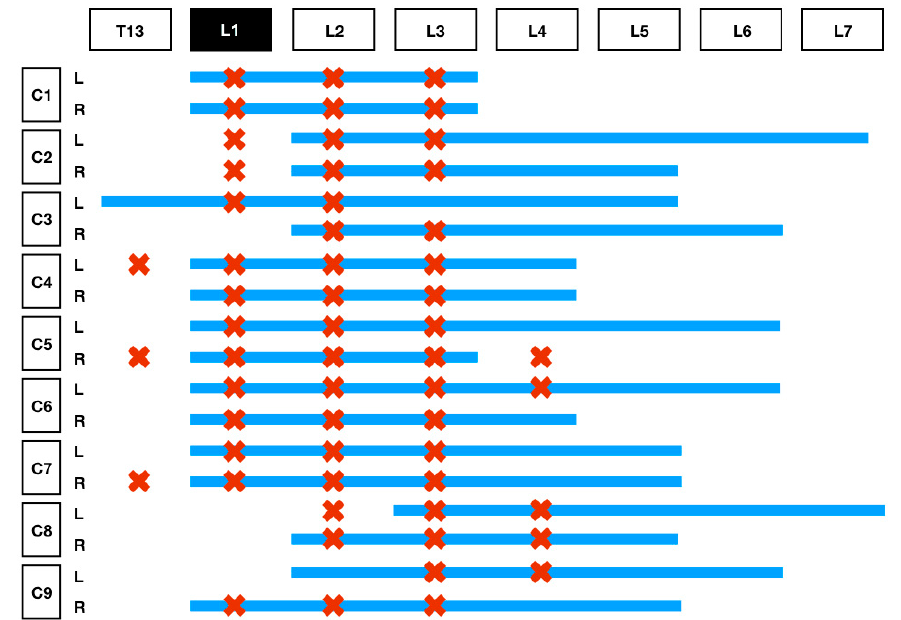
Figure 4. This table represents the difference in the extent of diffusion of the 50:50 iohexol/methylene blue mixture observed during CT versus dissection. The Y -axis of the graph represents the spread of the mixture from T13 to L7 using the red Xs to show the spread noted on the ventral branches of the nerve roots on dissection, while the blue line represents the distribution around the vertebral bodies seen on CT. The X -axis represents the 9 carcasses used in this study, comparing the left- and right-sided blocks.